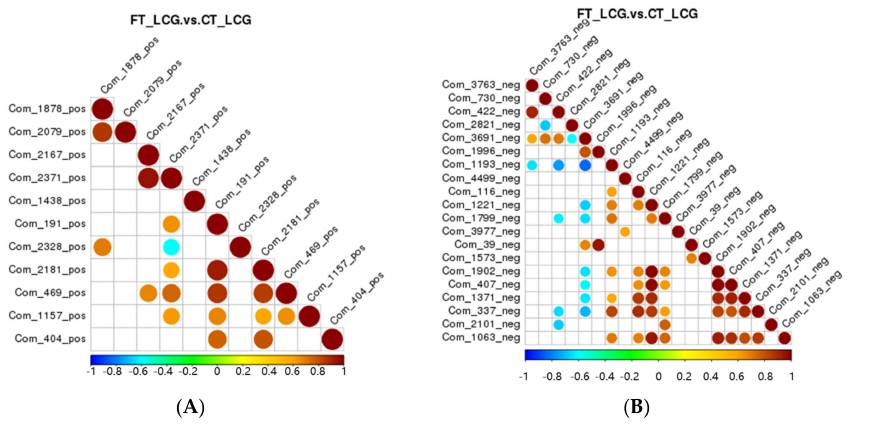
Figure 9. Differential metabolite correlation diagram (( A ): positive mode; ( B ): negative mode). Red denotes positive correlation, and the highest correlation is 1. Blue means negative correlation, and the lowest correlation is − 1. p > 0.05 is true of the portion without color. The top 20 differential metabolites are correlated in the figure in order of p -value from minimum to